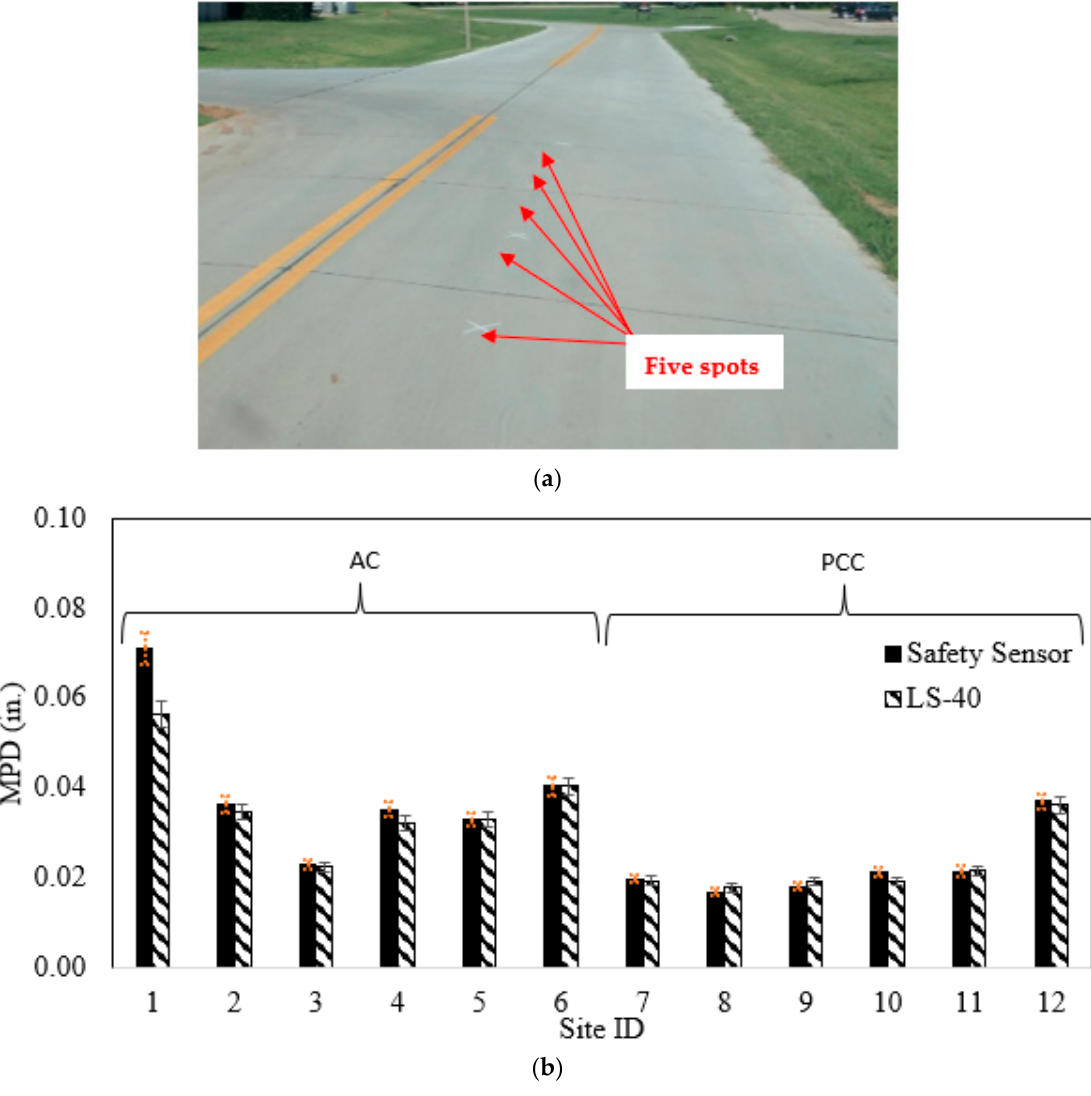
Figure 5. Field data collection and MPD results: ( a ) Field data collection, and ( b ) Summary of average MPD.